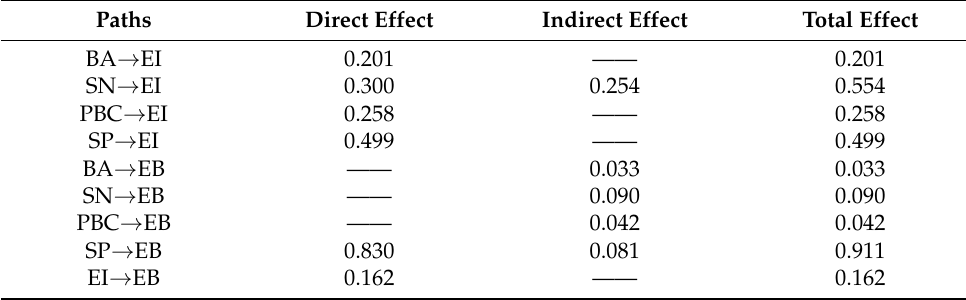
Table 7. Direct, indirect and total effects for the Structural Equation